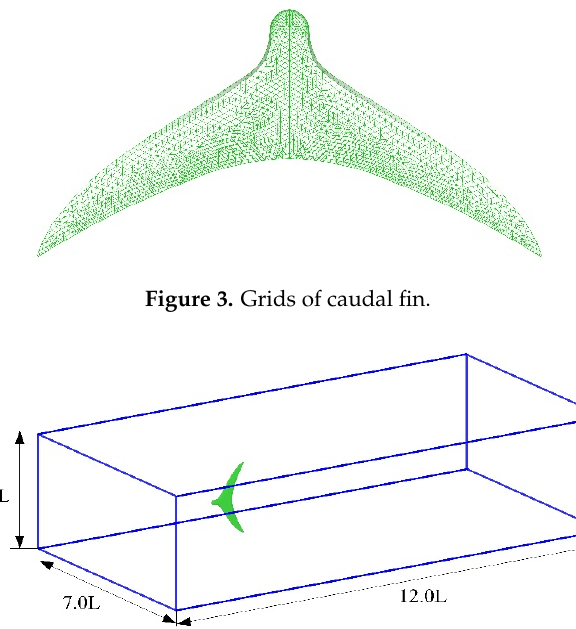
Figure 4. Schematic of computational domain.